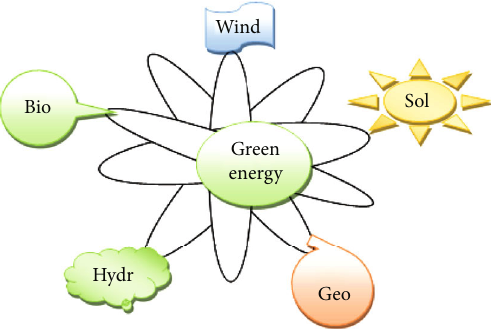
Figure 1: Di ff erent green energy sources. Bio: biomass energy; Hydro: hydropower energy; Geo: geothermal energy; Sol: solar energy; Wind: wind energy.